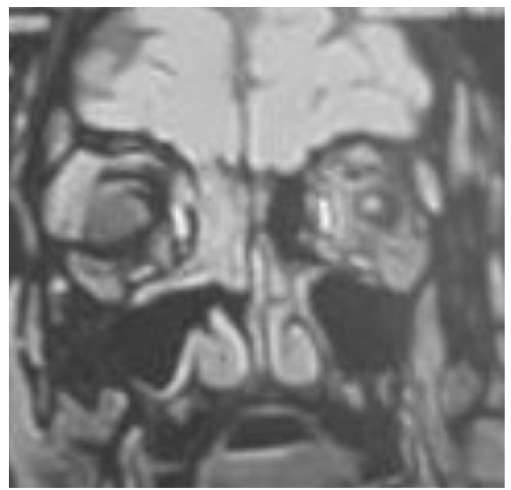
Figure 3. Female patient with C.A.M. presented by Rt. Maxillary and ethmoid sinuses involvement.